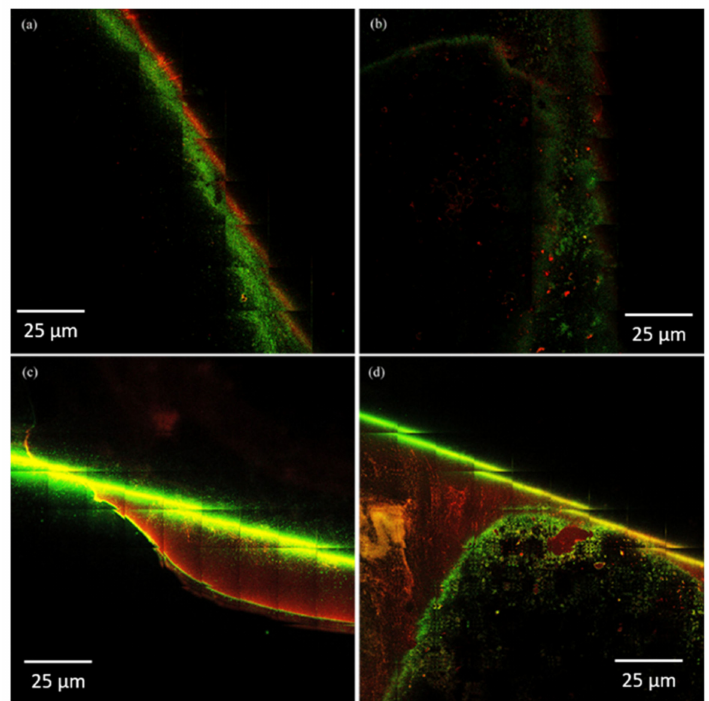
Figure 3. Photon images of biofilms of different microorganisms formed on the surface of dental porcelain Ex-3 Noritake incorporated with β -AgVO 3, acquired by multiphoton microscope. Green: viable cells (live); red: non-viable cells (dead). ( a ) Streptococcus sobrinus biofilm on the surface of the control group; ( b ) S. sobrinus biofilm on the surface of the 5% group; ( c ) Pseudomonas aeruginosa biofilm on the surface of the control group; ( d ) P. aeruginosa biofilm on the surface of the 5% group. Table 2. Different times of silver and vanadium ions release (ppm) of dental porcelains incorporated with β -AgVO 3 . Ag + V 4+ /V 5+